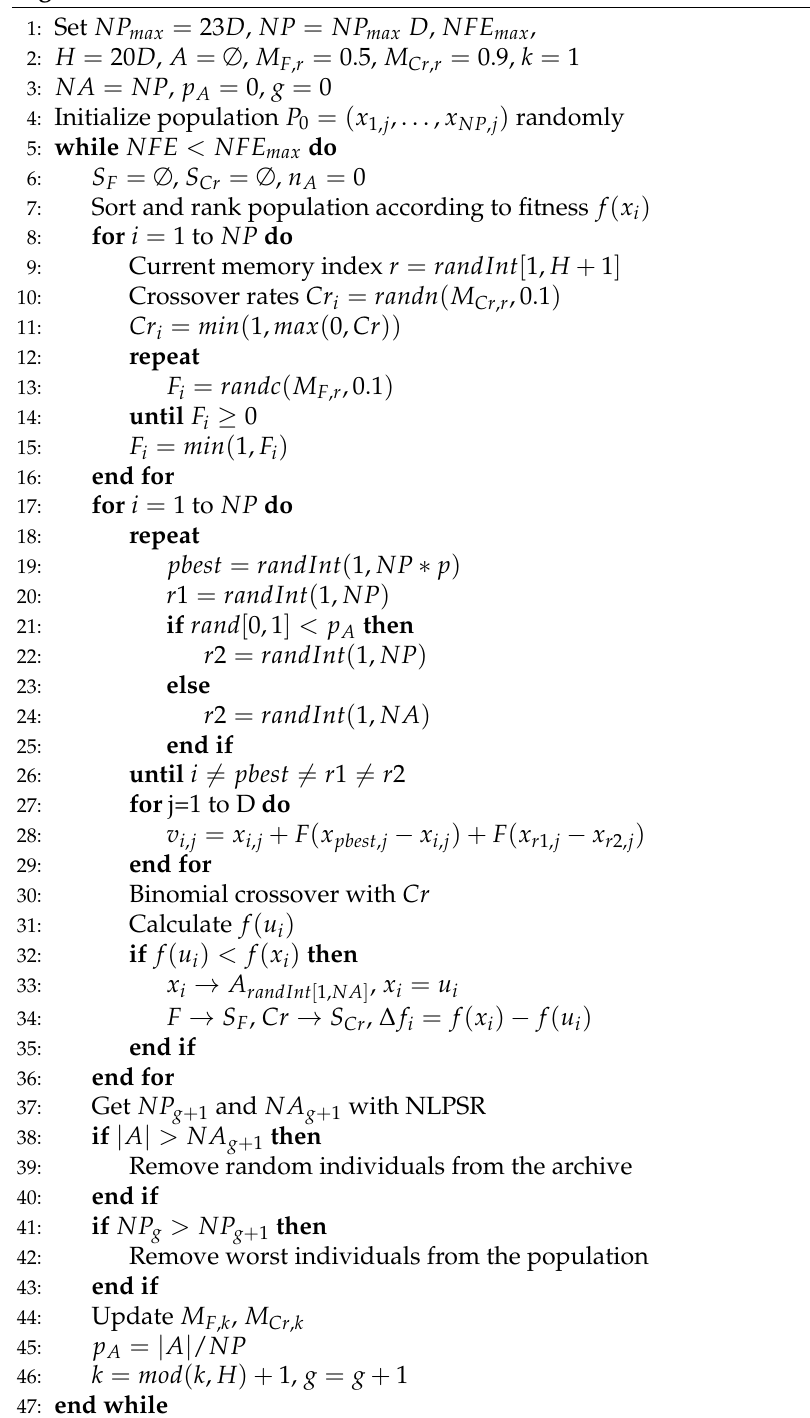
Algorithm 2 NL-SHADE-RSP